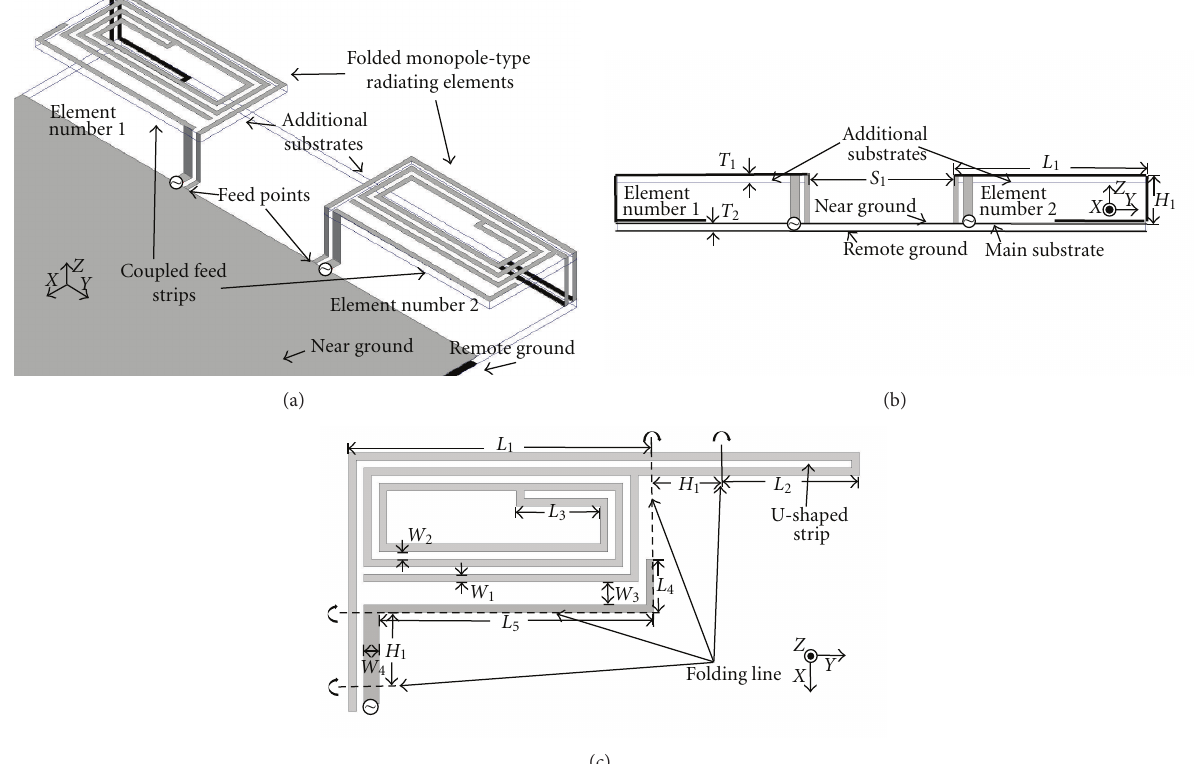
Figure 1: Geometry of the proposed MIMO antenna: (a) perspective view of the antenna, (b) front view of the antenna, and (c) unfolded view of a single antenna element.